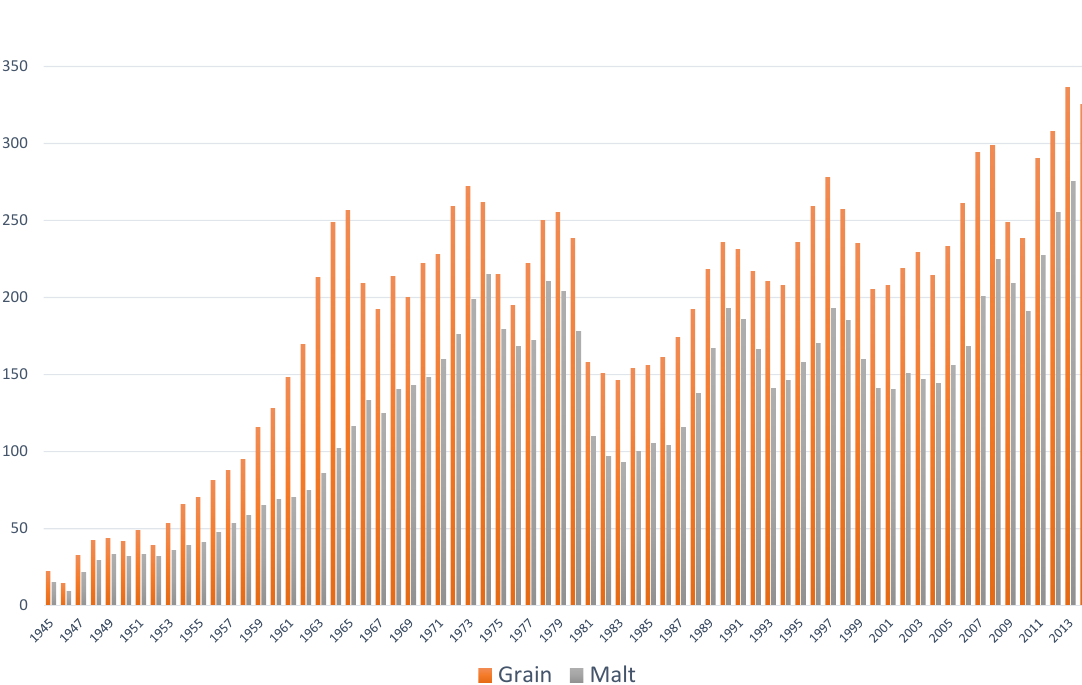
Figure 2. Scotch whisky production. Annual totals of malt and grain spirit produced in millions of liters of pure alcohol (mlpa). Sourced from SWA statistics and The making of Scotch whisky as outlined above.